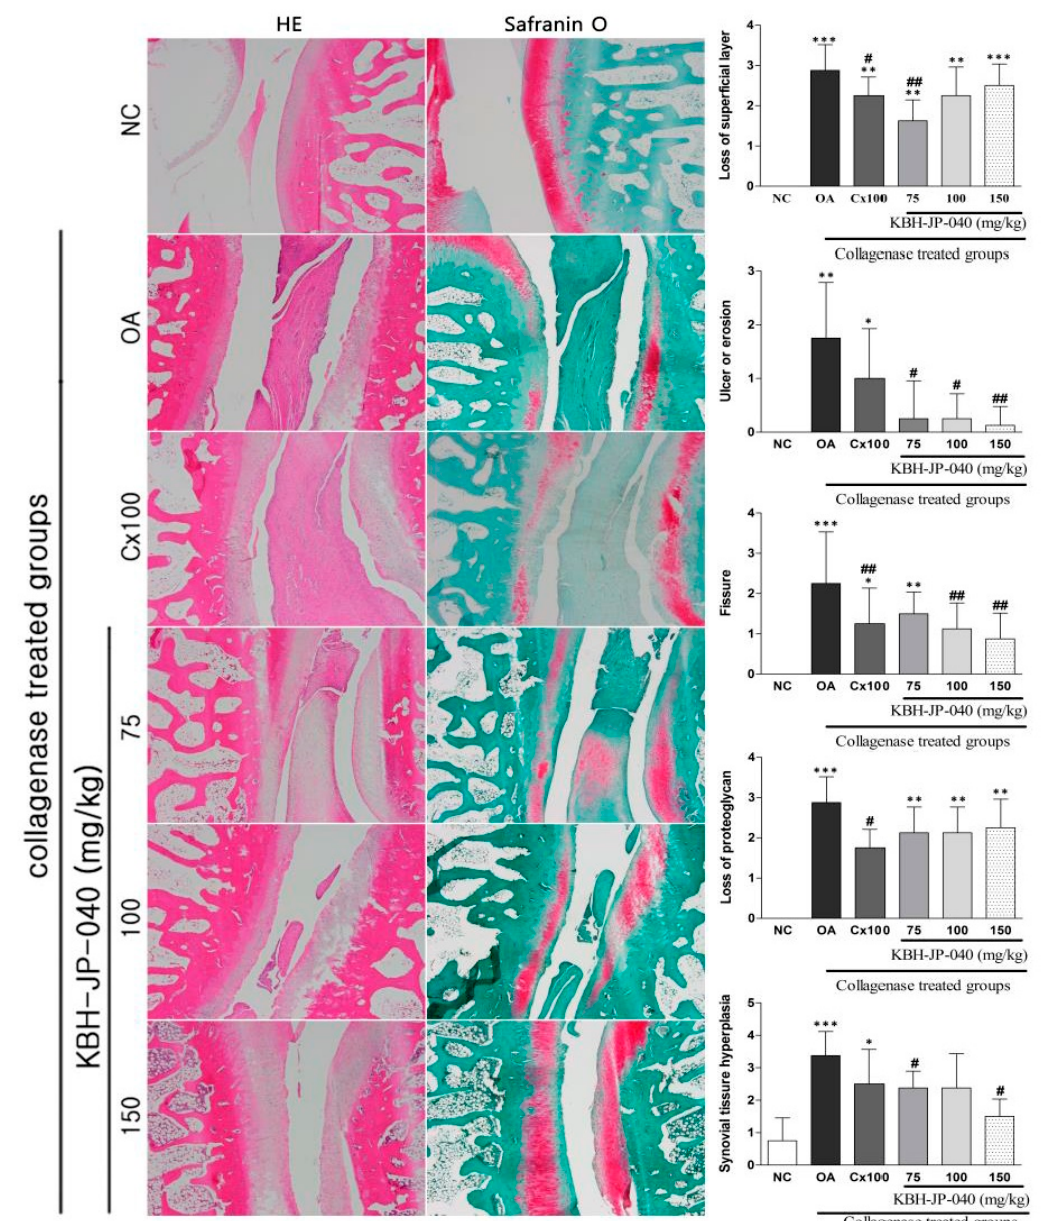
Figure 6. Evaluation of therapeutic efficacy of KBH-JP-040 by histological images of joints. NC, vehicle-treated normal control group; OA, vehicle-treated collagenase-induced osteoarthritis group; Cx100, collagenase-induced OA rabbits treated with celecoxib 100 mg/kg; collagenase-induced OA rabbits treated with standardized extract, KBH-JP-040-treated groups (75, 100, and 150 mg/kg body weight). The data are reported as means ± SD ( n = 10). *: p < 0.05; **: p < 0.01; and ***: p < 0.001, Bonferroni post hoc test following one-way ANOVA versus the NC group; #: p < 0.05; ##: p < 0.01, Bonferroni post hoc test following one-way ANOVA versus OA group.